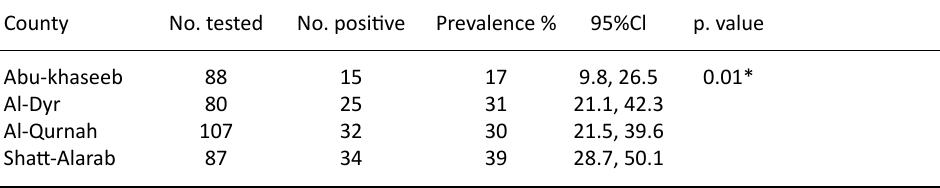
Table 4. Univariable analysis compared the association of the seroprevalence of Brucella and risk factors of animal practices and management adopted by owners Factor Test results Odd ratio (95% Cl) p. value No. Positive No. Negative